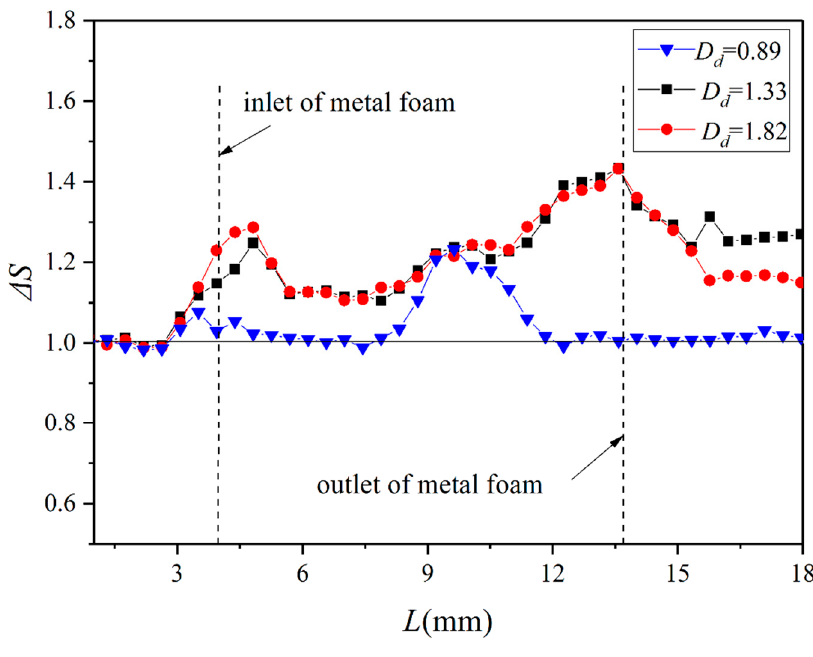
Figure 8. Change of the superficial area of the droplet passing through metal foam with different D d values ( L d = 7.32; Ca = 0.061).